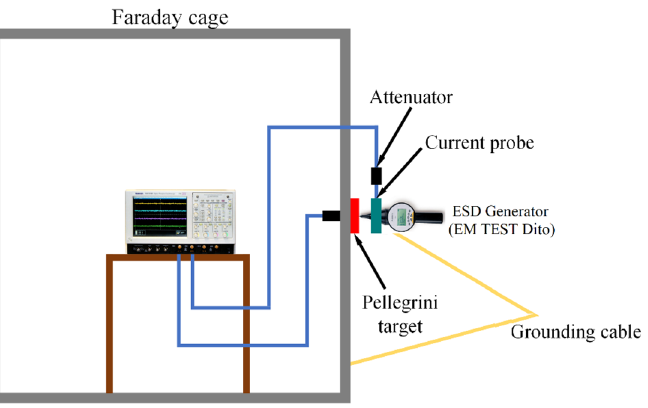
Figure 4. Test setup for measurements of the EM TEST Dito ESD generator via the F-65 current probe and the Pellegrini target.